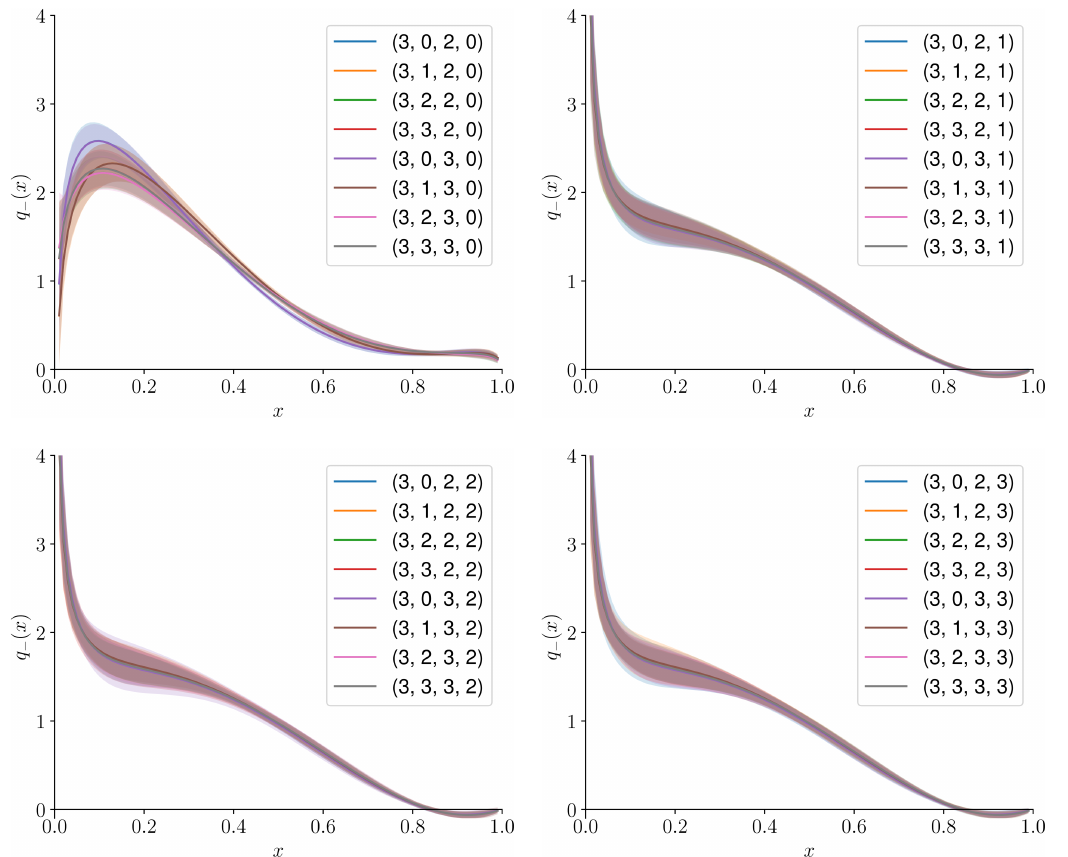
Figure 16 . The PDF results from fitting the real component to the models. The numbers in the legend correspond to ( N ± , N